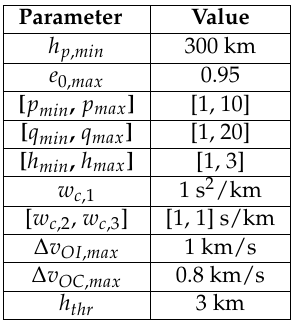
Table 7. Parameters and bounds supplied as inputs to the co-orbital mission concept design.